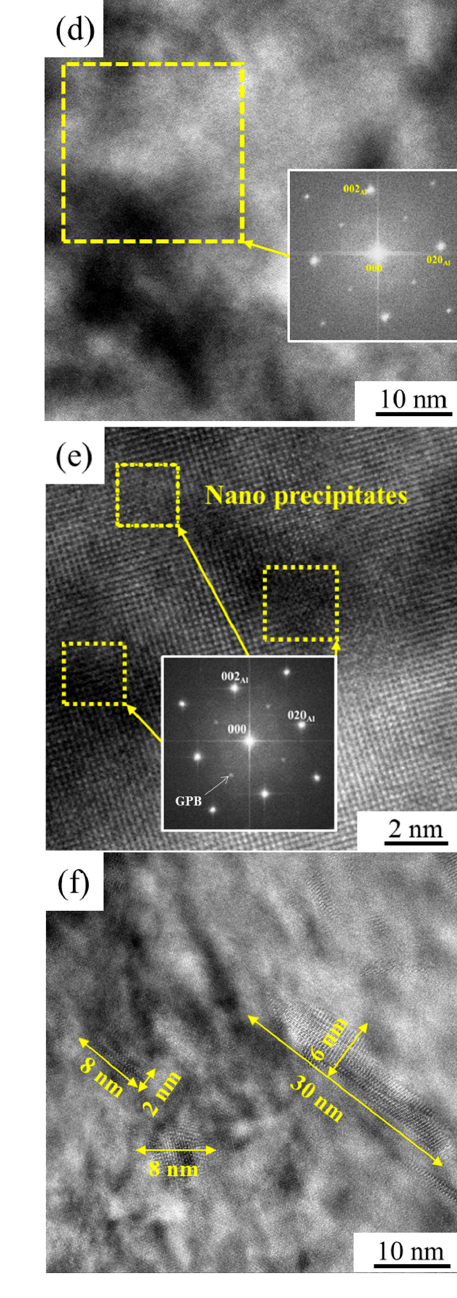
Figure 8. TEM micrographs of the cold-rolled (CR) sample under different post-aging conditions: ( a ) CR@80 °C/48 h, ( b ) CR@100 °C/12 h, ( c ) CR@180 °C/6 h; HRTEM images: ( d ) and ( e ) showing uniformly distributed nanosized precipitation regarding ( a ) and ( b ), ( f ) showing S precipitates regarding ( e ). Insets in ( c – e ) are the corresponding SAED and FFT